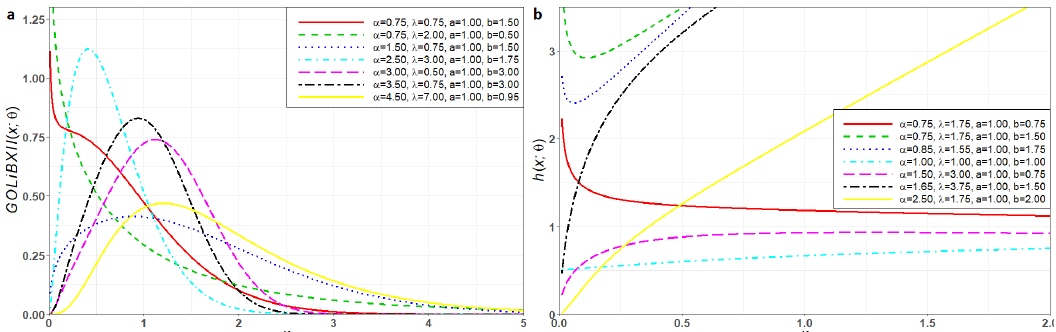
Figure 2 - Plots of the GOLiBXII pdf ( a ) and hrf ( b ) for some parameter